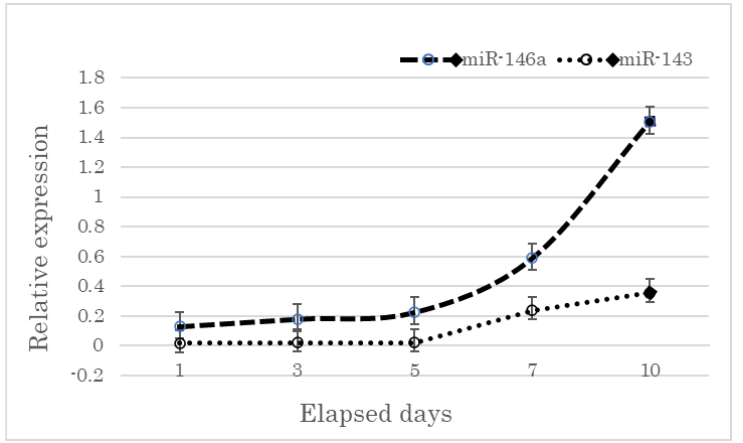
Figure 2. Expression levels of miR-146a and miR-143 in plasma samples of the healthy volunteers kept at room temperature for different days.